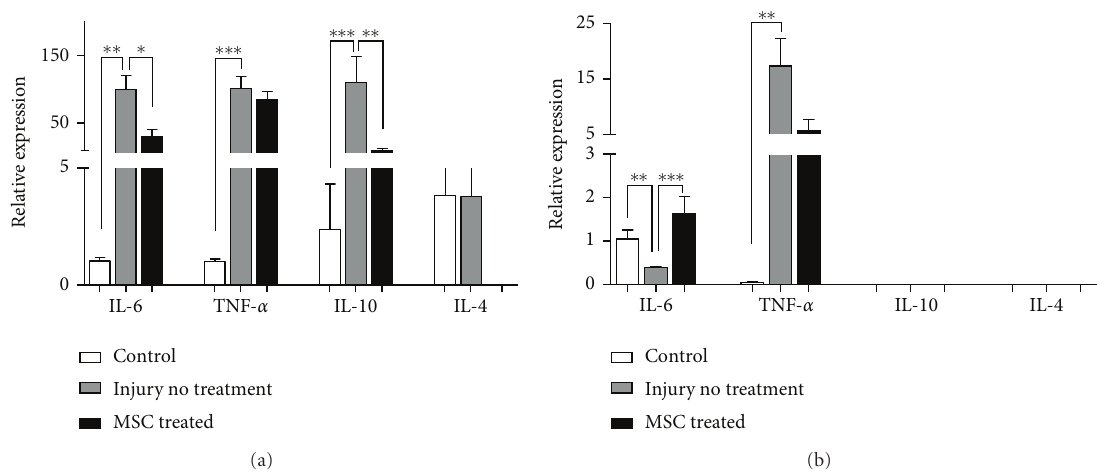
Figure 1: Relative expression of IL-6, TNF- α , IL-10, and IL-4 in acute and chronic models of motor cortex injury. (a) 24 hours and (b) 30 days after injury and MSC injection, RNA was extracted from motor cortex of control, injury without treatment and MSC treated mice. qPCR was performed to quantify the expression of inflammatory cytokines and relative expression was calculated in relation to HPRT. Data are expressed as mean of 2 − ΔΔ Ct ± SEM (control n = 3, injury no treatment n = 6, MSC treated n = 4). ∗ P < . 05, ∗∗ P < . 001, ∗∗∗ P < . 0001.